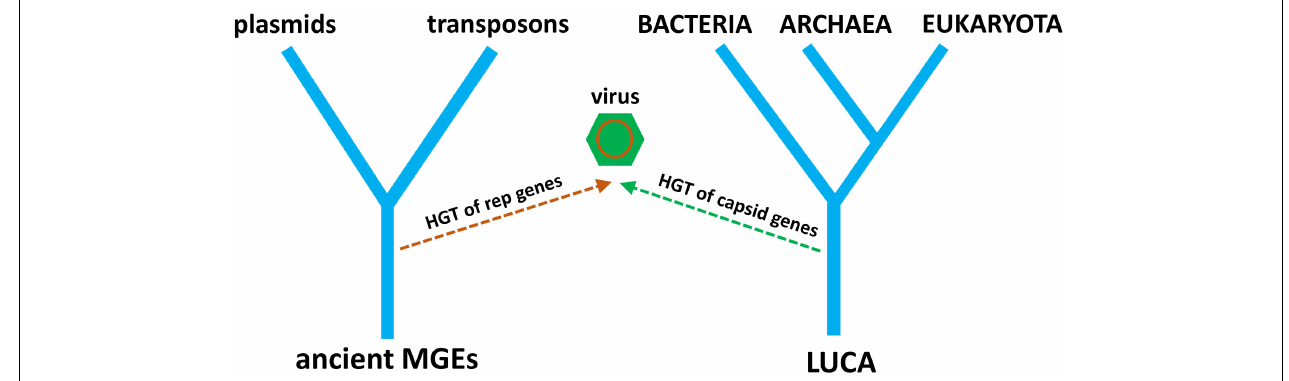
FIGURE 6 | A simple tree diagram showing the chimeric origin of viruses from pre-LUCA replication genes and post-LUCA structural genes. Ancient MGE ancestors replace ancient cells (from Figure 4 ), reflecting the origin of virus replication genes from MGEs. The evolution of modern plasmids and transposons from ancient MGEs is also